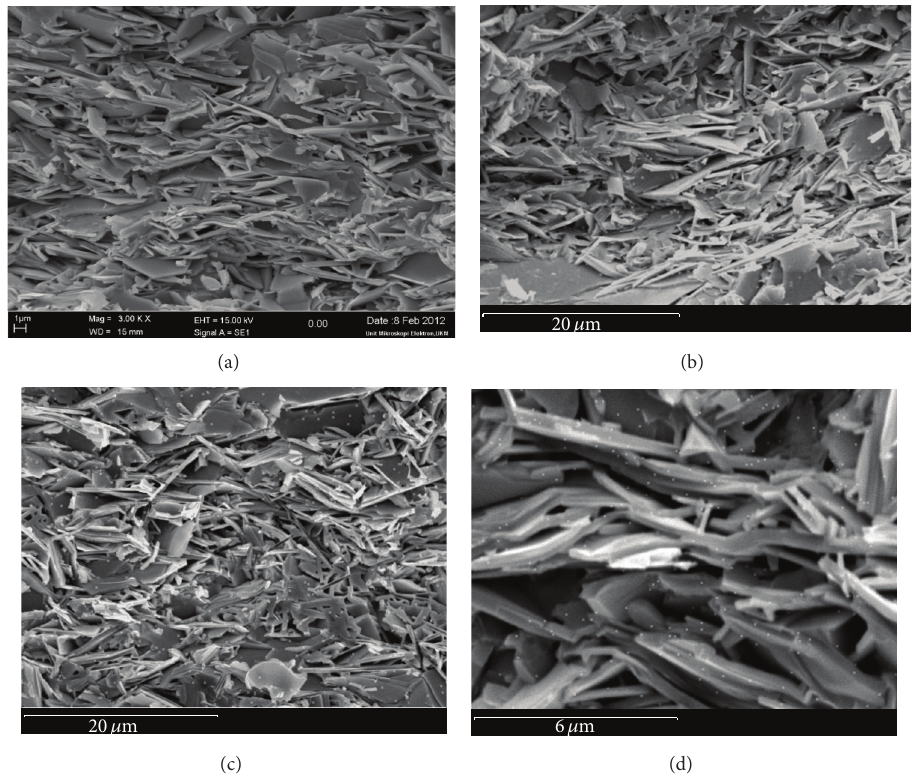
Figure 7: SEM micrographs of (a) non-Co 3 O 4 added sample, (b) added with 10nm Co 3 O 4 ( 𝑥 = 0.03 wt.%), (c) added with 30 nm Co 3 O 4 ( 𝑥 = 0.02 wt.%), and (d) added with 50 nm Co 3 O 4 ( 𝑥 = 0.01 wt.%). White dots are Co 3 O 4